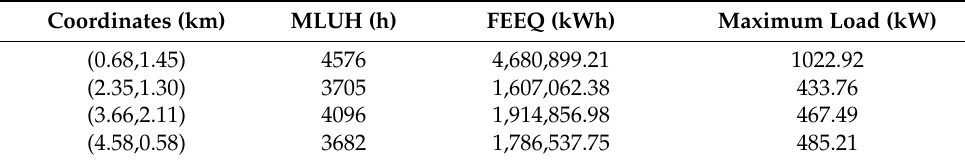
Table 6. The data on